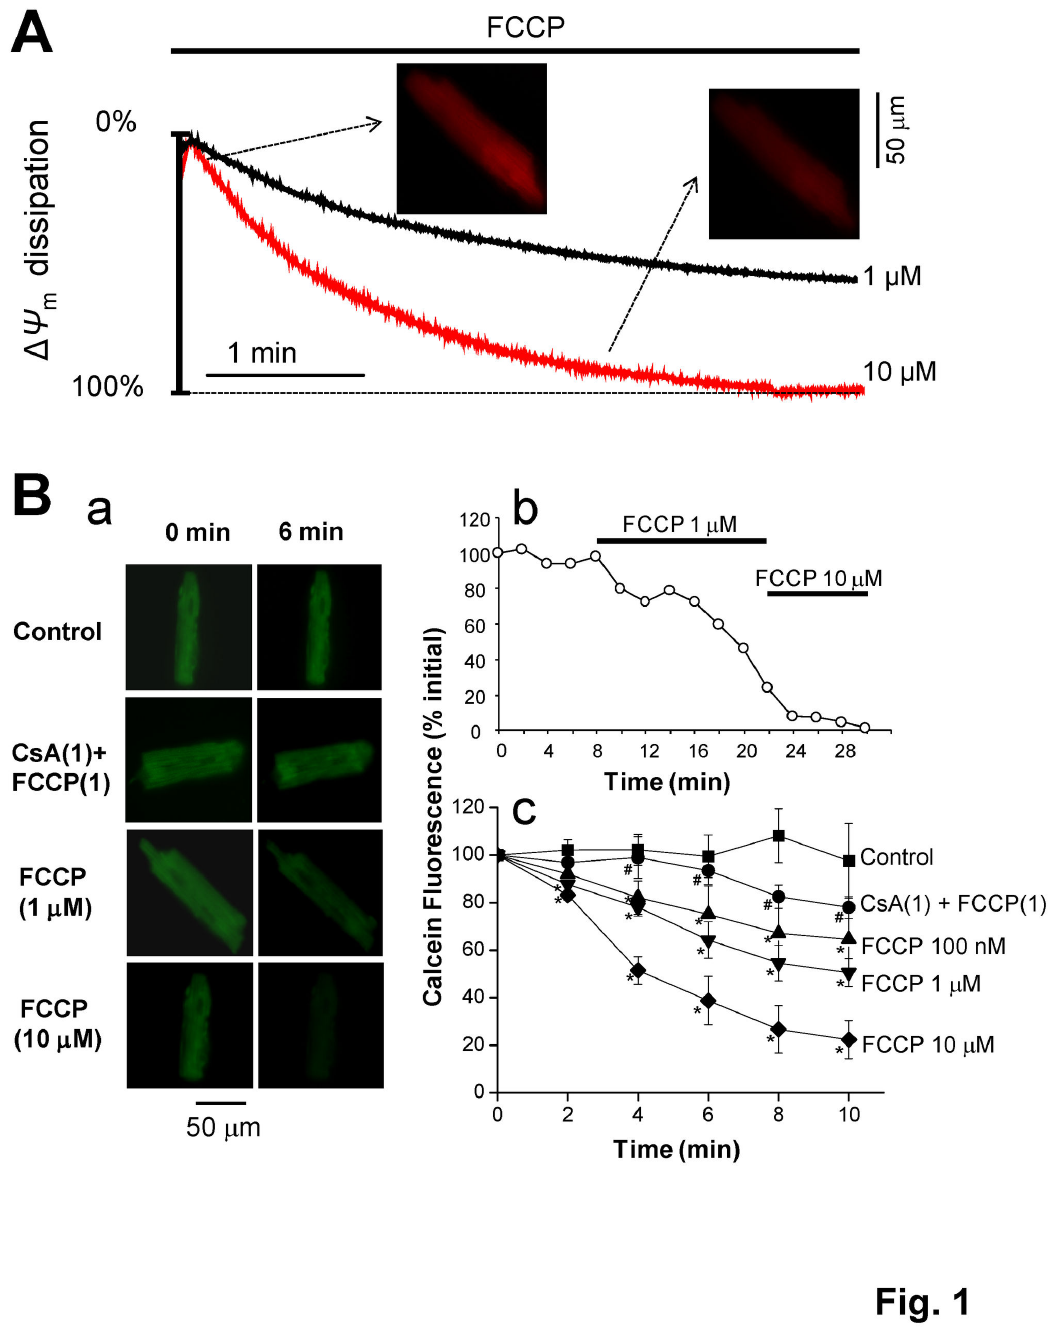
Figure 1. Effect of FCCP on mitochondrial membrane potential (Δ Ψ ) and mPTP opening in isolated mouse ventricular m myocytes. A . TMRM fluorescence was monitored as an indicator of Δψ . FCCP (1 and 10 µM) was perfused as indicated by the m horizontal bar. Two snapshots of TMRM fluorescence (control and ~2.5 min after the treatment with 10 µM FCCP) are shown. The fluorescence in the presence of 30 µM FCCP was set as 100% dissipation in each cell. B . Calcein fluorescence intensity was monitored as an indicator of mPTP opening. B - a . Two snapshots of calcein fluorescence at baseline (0 min) and 6 min after the treatment with FCCP (1 and 10 µM) and FCCP (1 µM) + CsA (1 µM). B - b . A representative recording of calcein fluorescence showing the rate of fluorescence decline in the presence of 1 and 10 µM FCCP. B - c . Summary data showing the calcein fluorescence decline in the presence of FCCP (100 nM, 1 and 10 µM) and CsA + FCCP as indicated. The fluorescence in the presence of 30 µM FCCP was set as 0% in each cell. * p < 0.05 vs. Control; # p < 0.05 vs. FCCP (1 µM). doi: 10.1371/journal.pone.0080574.g001 PLOS ONE |